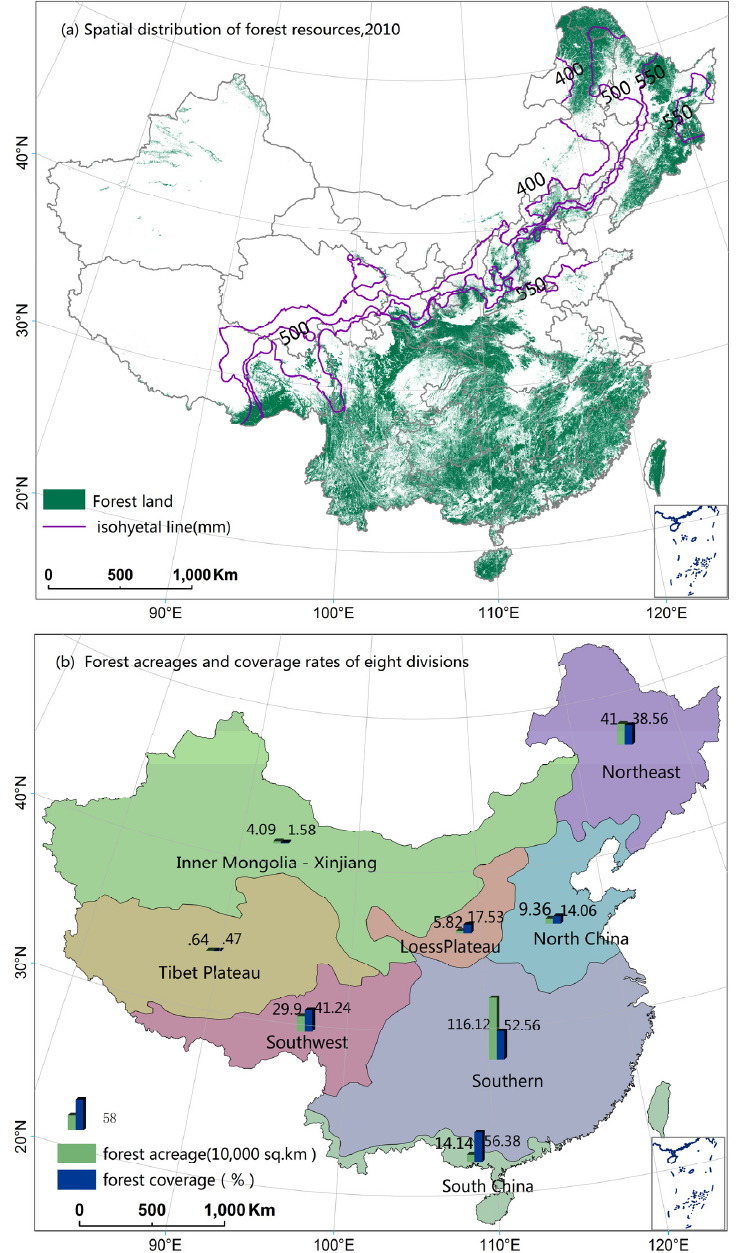
Figure 3. Geographical distribution of forest in China, 2010.